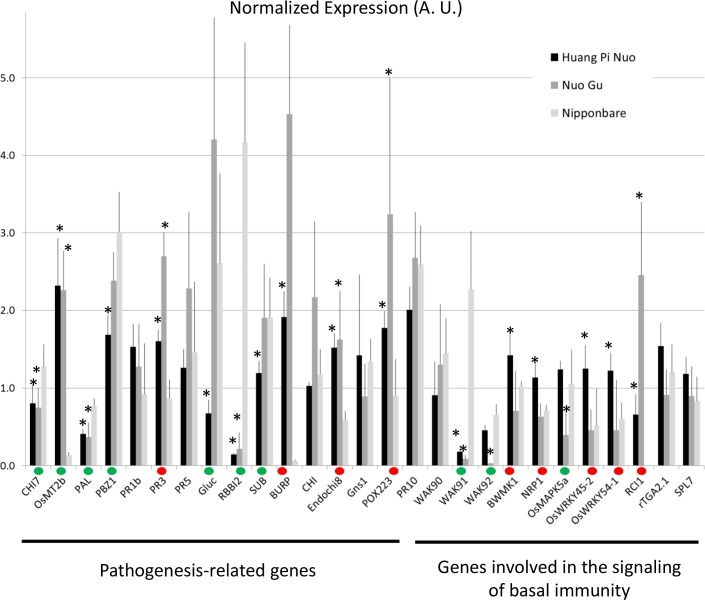
Chitin-induced expression of defense-related genes in Yuanyang japonica and Nipponbare varieties.The japonica variety Nipponbare with high basal immunity was compared to the Yuanyang japonica varieties Huang Pi Nuo and Nuo Gu. The expression of 16 pathogenesis-related genes and 11 genes involved in basal immunity signaling was measured by RT-qPCR 24 hr after chitin treatment (100 ug/mL). In order to compare all genes together, all values for one gene were normalized with the average value of the considered gene for all measures. The values are the means and SD from four biological replicates. The ‘*’ denote statistical differences (t-test; p<0.05) between Nipponbare and the considered variety. A red and green dot indicates that Nipponbare expression is lower and higher than either Huang Pi Nuo or Nuo Gu respectively.